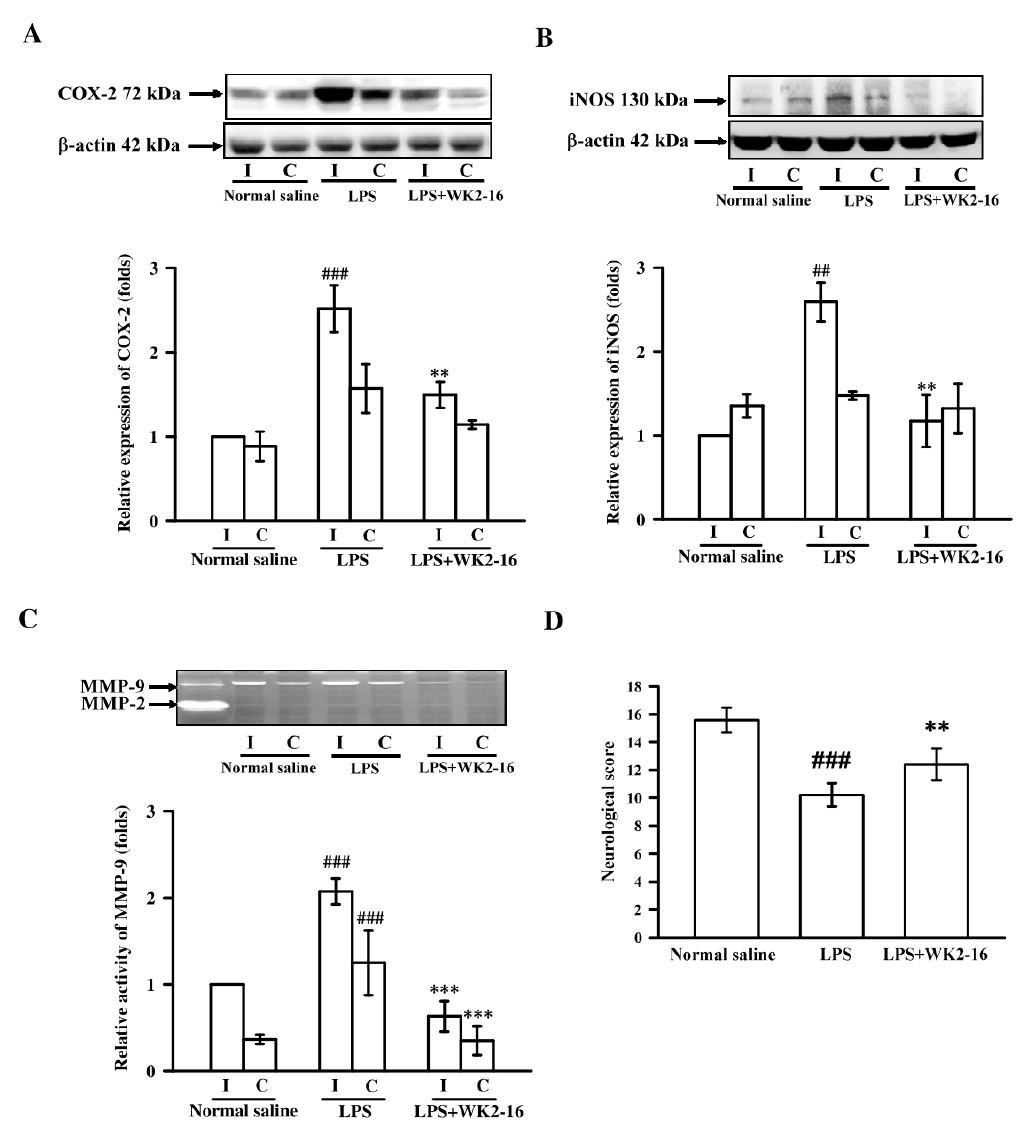
Figure 1. WK2-16 suppressed inflammatory mediator production and protected against functional neurological deficits in LPS-induced neuroinflammation in C57BL6 mice. Protein levels of ( A ) COX-2 and ( B ) iNOS were assessed eight hours after intrastriatal normal saline or LPS injection (4 µ g/3 µ L) in the presence or absence of WK2-16 (30 mg/kg) using Western blotting. The results are expressed as fold changes normalized to β -actin. ( C ) MMP-9 gelatinolytic activity in brain tissue